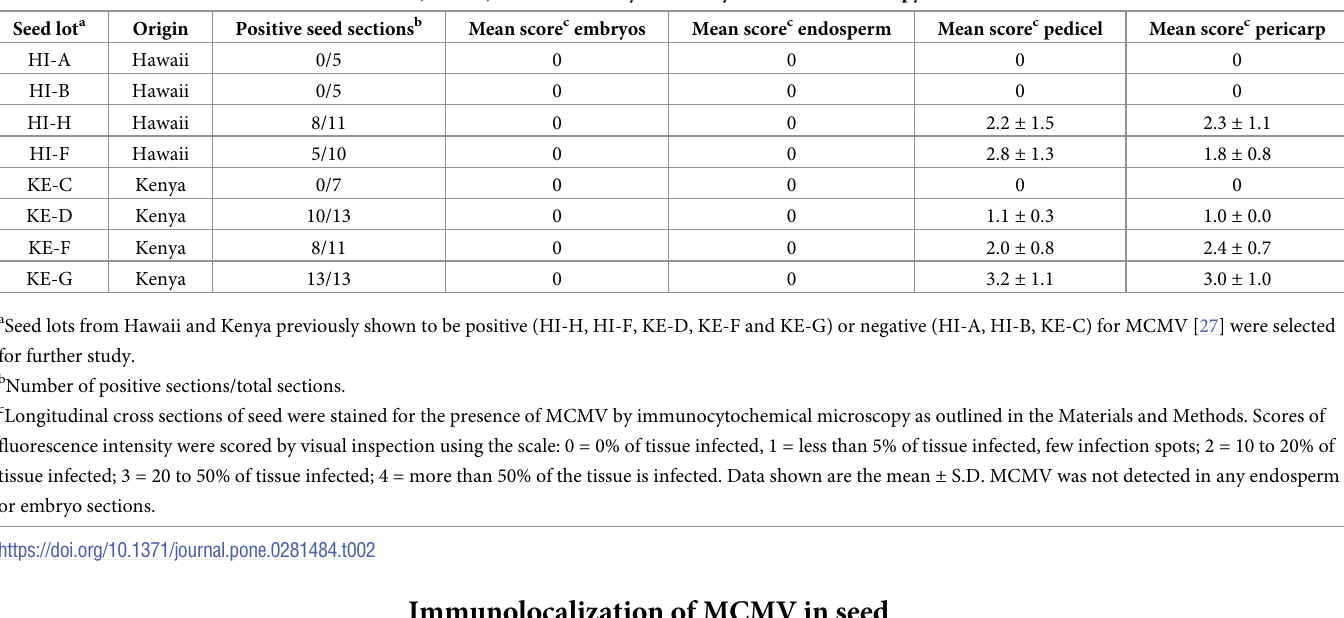
Table 2. Detection of maize chlorotic mottle virus (MCMV) in seed tissues by immunocytochemical